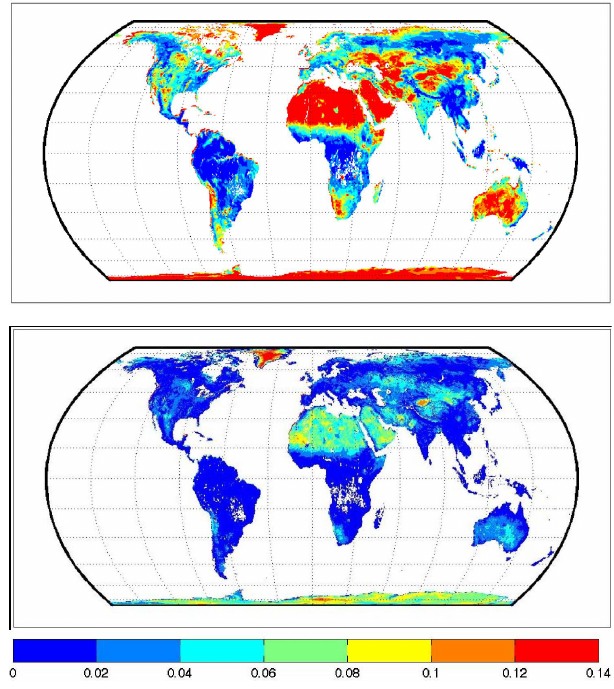
Fig. 3. Difference between vertical and horizontal polarizations land surface emissivity at 6.9GHz (top), and 89.0GHz (bottom) for January